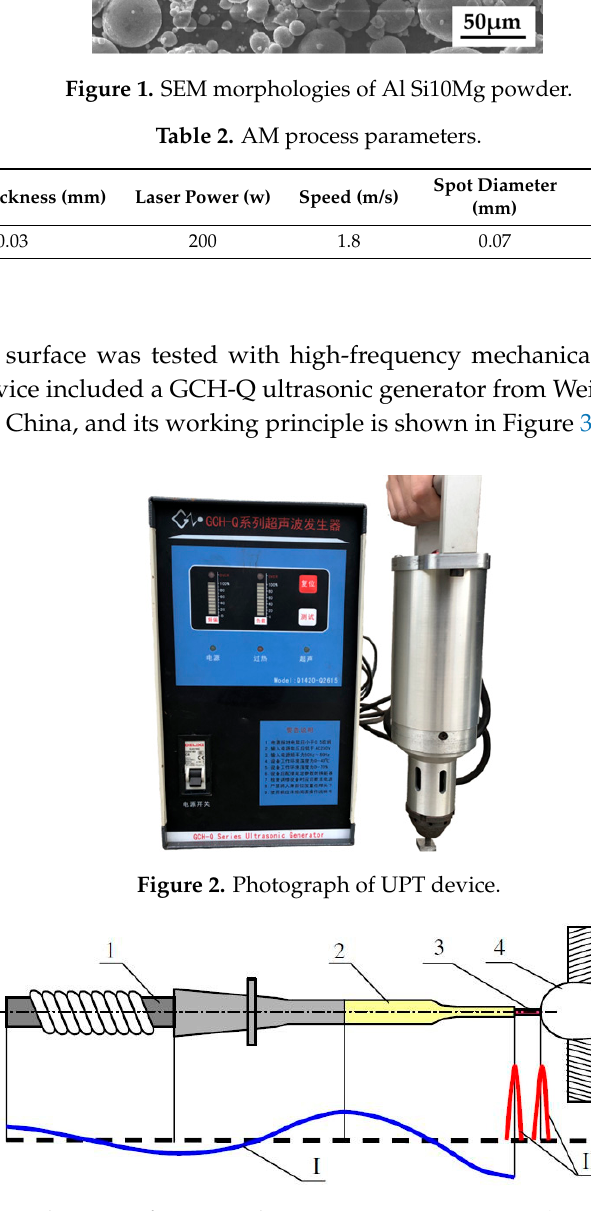
Table 2. AM process parameters.